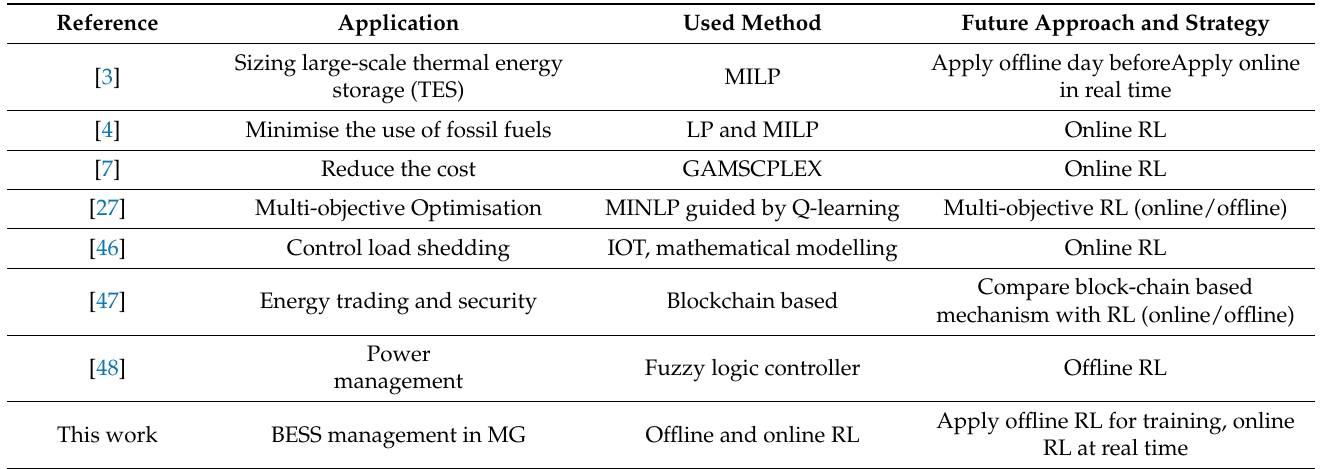
Table 2. Proposed offline and online RL on the current application